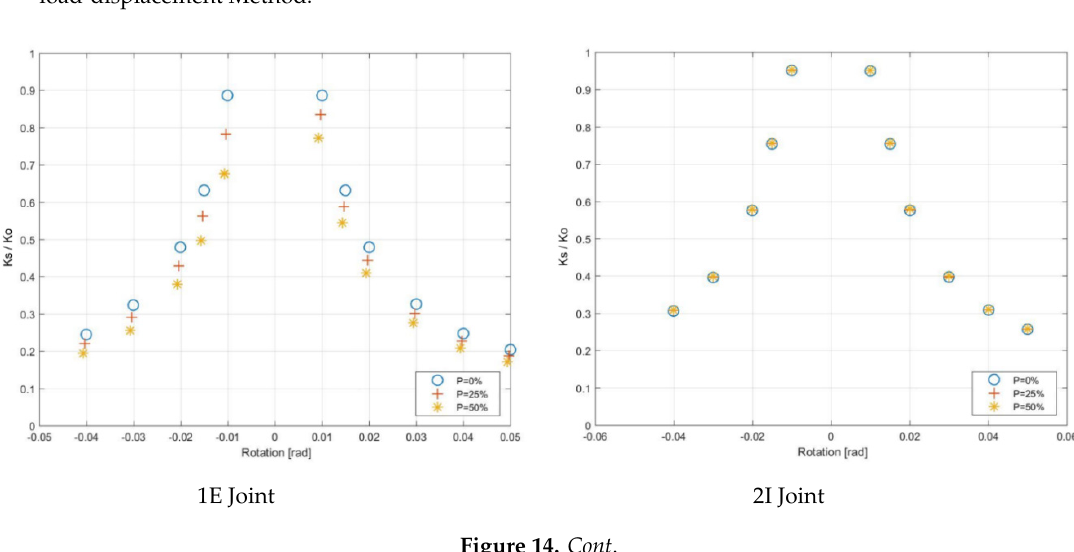
Figure 13. Summary of Tangent Stiffness vs. Rotation according to equivalent load-displacement Method.